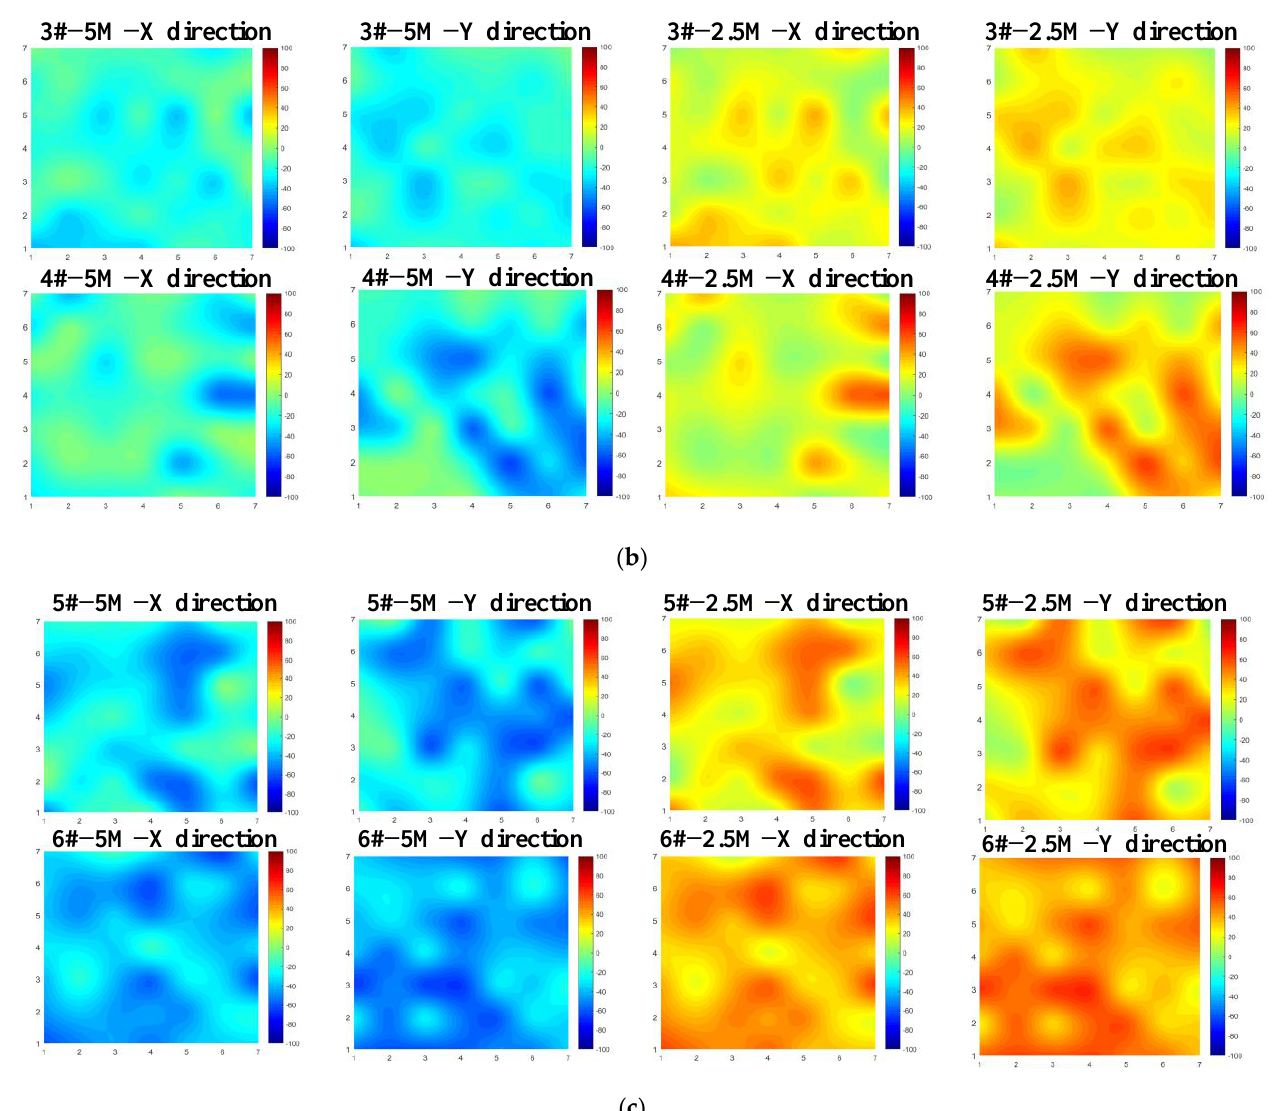
Figure 8. Residual stress distribution cloud diagram after milling 1 mm. ( a ) 5A06 alloy blanks. ( b ) 6061 alloy blanks. ( c ) 7075 alloy blanks.